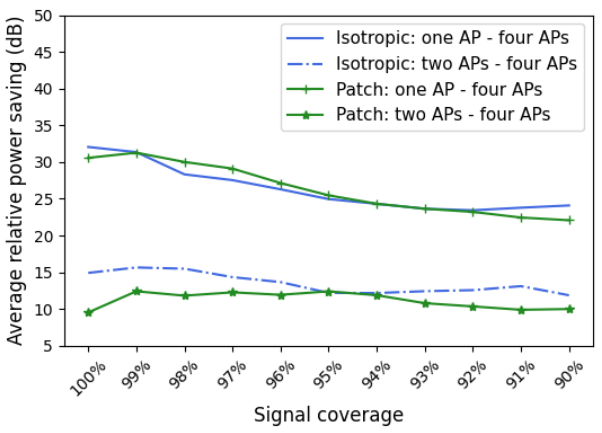
Figure 11. Impact of the total AP number on the D-mMIMO system’s performance (128 antennas in total) with optimized AP placements on the average relative power saving when the D-mMIMO system is equipped with four APs compared with one or two APs over all the